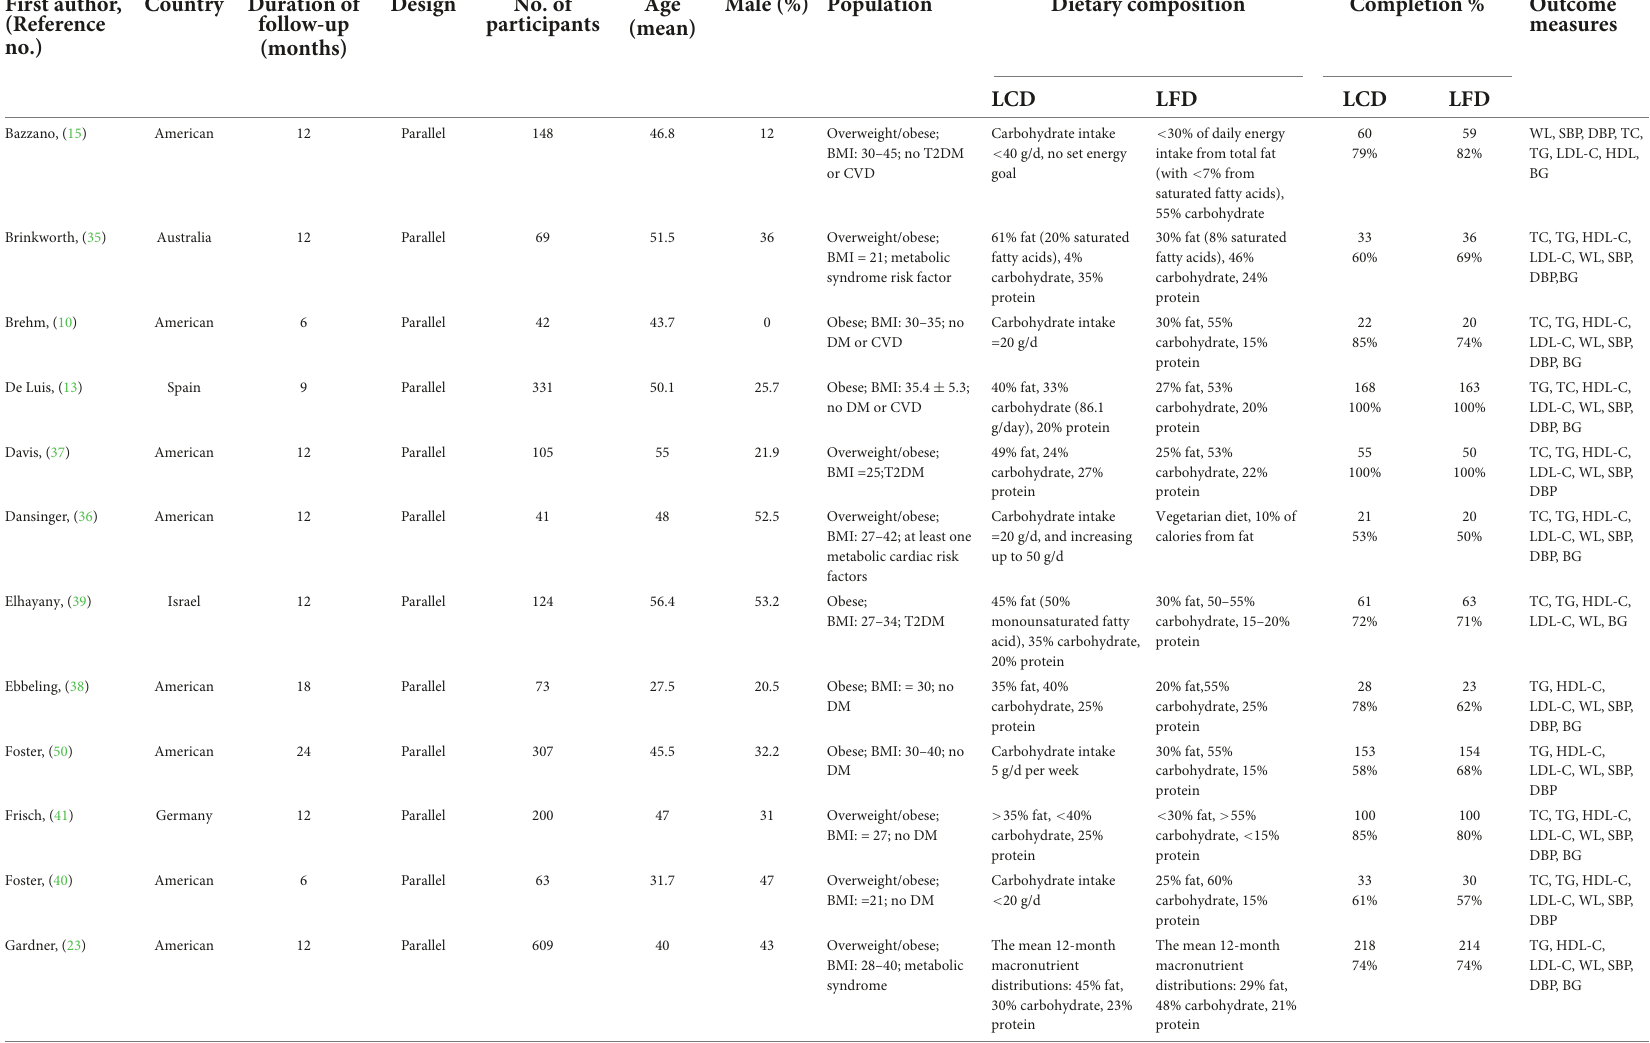
TABLE 1 Characteristics of randomized controlled trials included in the meta-analysis 1 .